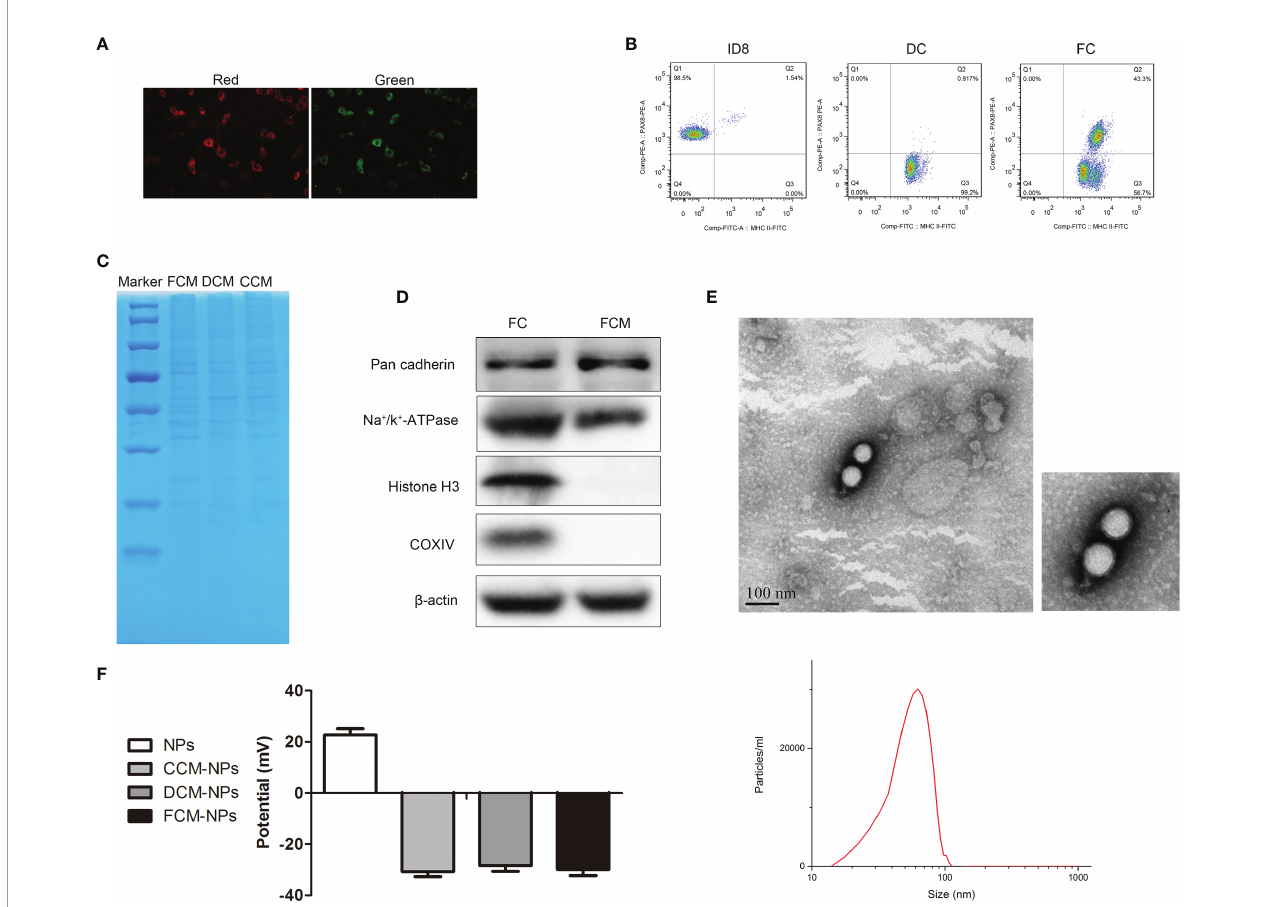
FIGURE 2 | Identi fi cation and characterization of FCM-NPs. (A) The fusion of DCs and OC cells was observed through CLSM, red fl uorescence of PKH26-labelled ID8 cells and green fl uorescence of CFSE-labelled DCs. Scale bar = 200 m m. (B) Flow cytometry analyses of the CD133-PE on ID8 cells, MHC II-FITC on DCs and the double-labeling on FCs. (C) SDS-PAGE analysis of the proteins of ID8 cell membrane (CCM), dendritic cell membrane (DCM) and fusion cell membrane (FCM). (D) Western blot analysis of the protein biomarkers of cell membrane, cytoplasm and nucleus in FC and FCM. (E) TEM images of FCM-NPs. Scale bar = 100 nm. (F) z -potential of the NPs, CCM-NPs, DCM-NPs and